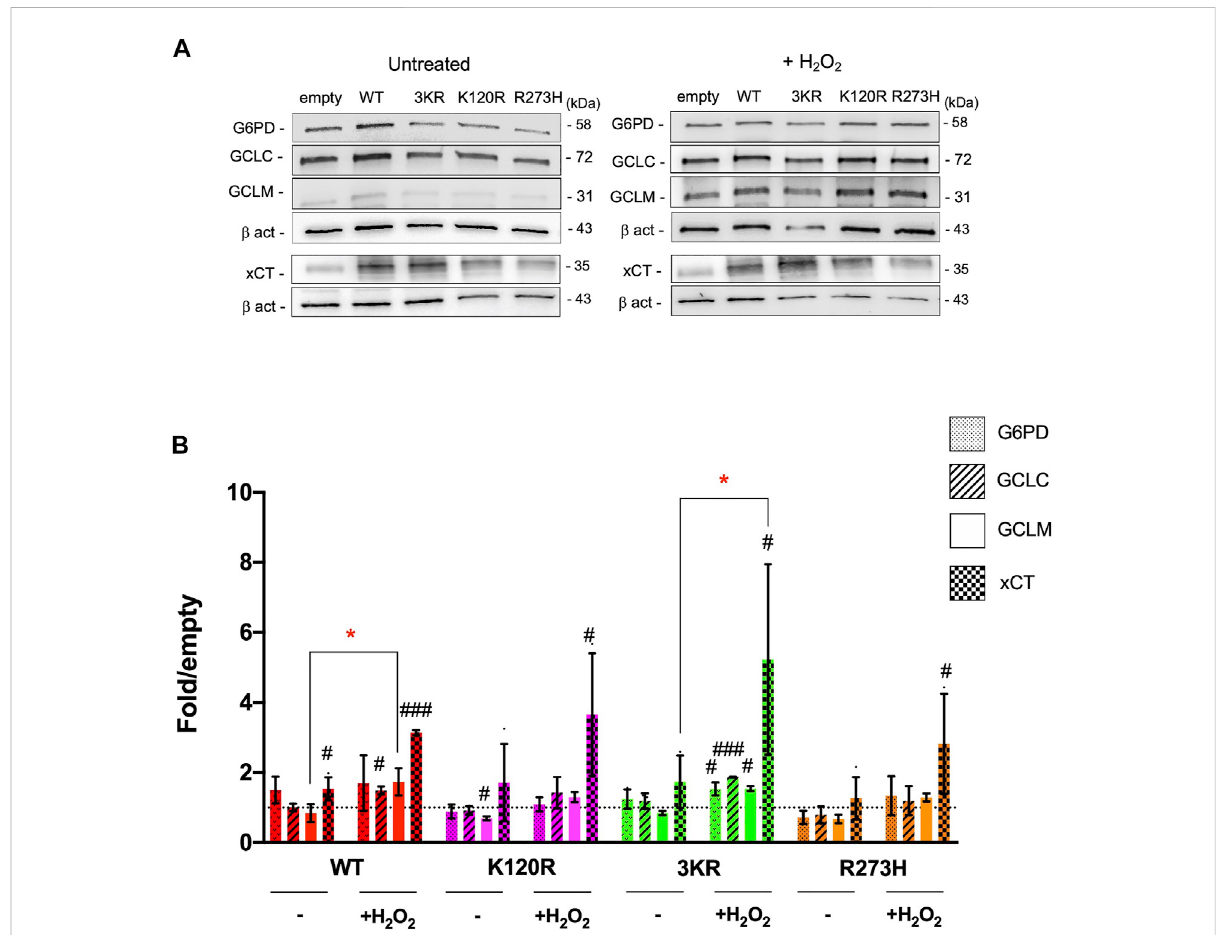
FIGURE 8 Modulation of proteins involved in the antioxidant response by p53 WT , p53 3KR , p53 K120R , and p53 R273H proteins in untreated and H 2 O 2 treated HCT116 TP53 − / − cells. (A) Representative western blots showing the level of G6PD, GCLC, GCLM, xCT and Beta-actin ( β -act) endogenous proteins in untreated and 100 μ M H 2 O 2 treated HCT116 TP53 − / − cells transiently expressing p53 WT , p53 K120R , p53 3KR , and p53 R273H . (B) Histograms representing the amount of G6PD, GCLC, GCLM, and xCT proteins detected in HCT116 TP53 − / − transfected cells in untreated or treated samples and normalized for β -act. Data were obtained after chemiluminescence analysis of western blots from at least two independent experiments and are reported as mean ± SD. The levels of the different proteins were calculated as fold over the level of the same proteins found in cells transfected with the empty vector (# p < 0.05; ## p < 0.005; ### p < 0.0005; t Student); the dotted line corresponds to one-fold over empty. The red symbol * indicates a signi fi cant difference for p ≤ 0.0295 between the H 2 O 2 treated and the indicated untreated